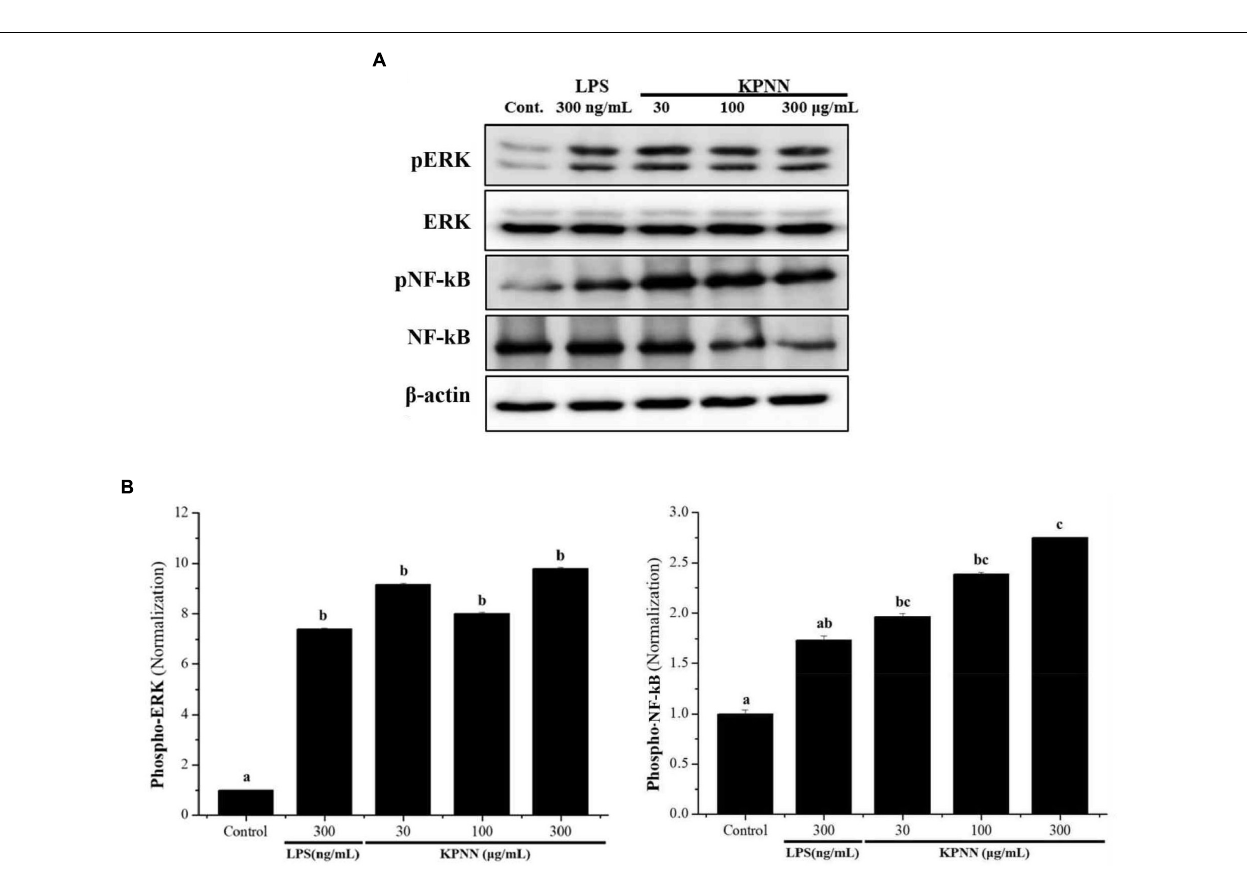
FIGURE 2 | Activation of ERK and NF- κ B by KPNN in RAW 264.7 cells. (A) RAW 264.7 were aliquoted at 1 × 10 6 cells/ml in a 100 mm dish/well and treated with KPNN (0, 30, 100, 300 µ g/ml) or LPS (300 ng/ml) and incubated for 24 h. The expression levels of phospho-ERK and phospho-NF- κ B were examined by western blot analysis using anti-NF- κ B p65, p-NF- κ B p65, p44/42 MAPK (Erk1/2), and p-p44/42 MAPK (Erk1/2) antibodies. (B) Western blots were quantified using the Quantity One 4.6.6 software. Values are presented as mean ± SEM ( n = 3). Bars labeled with different superscript numerals indicate p < 0.05.